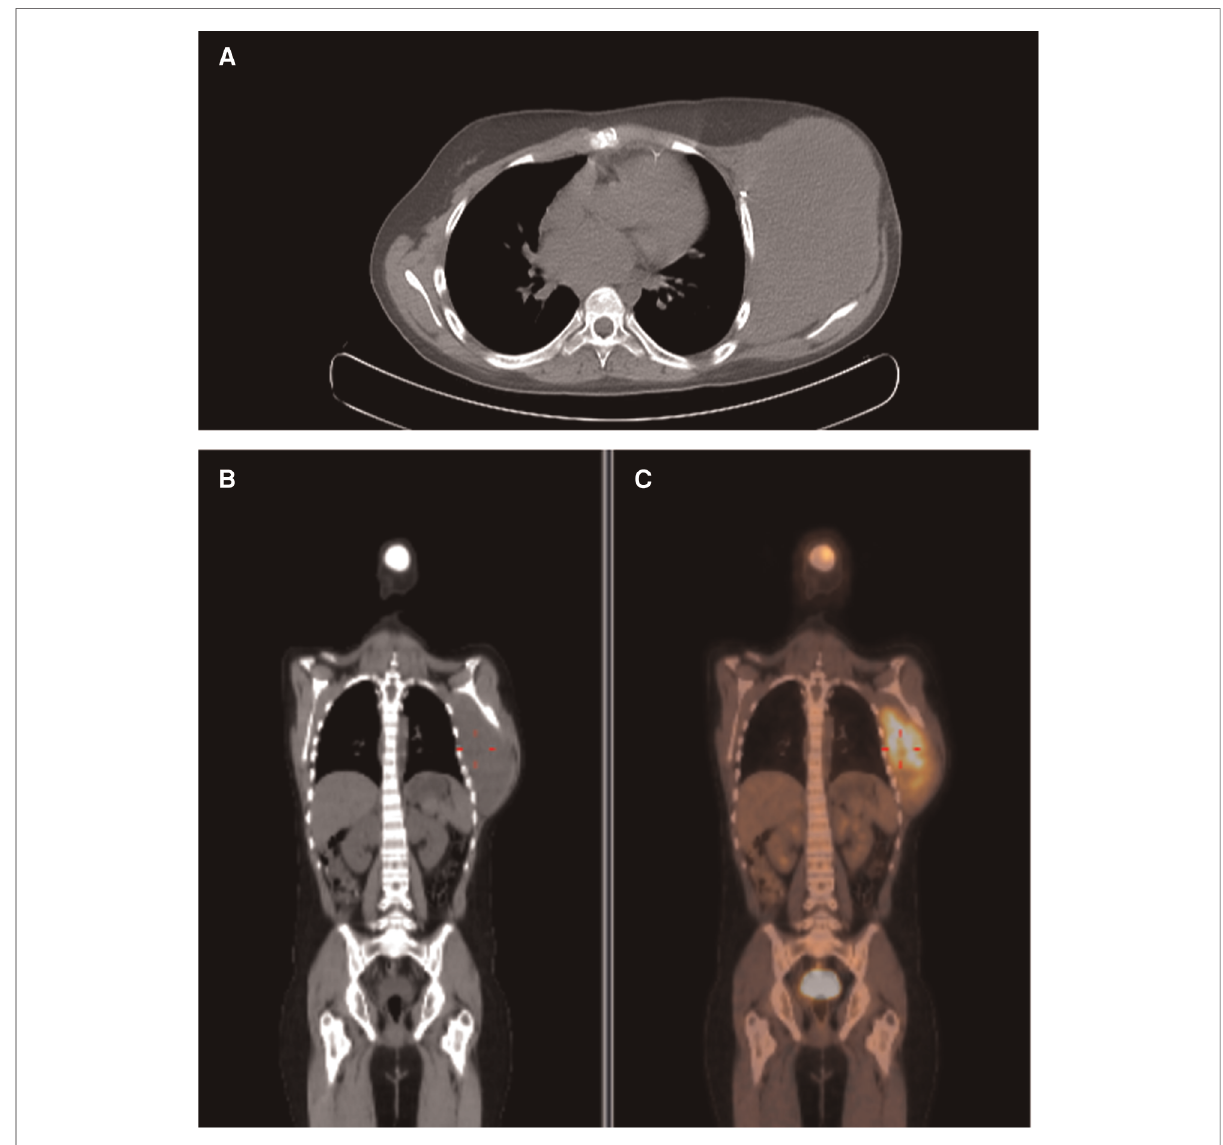
FIGURE 1 Preoperative PET image. Captant area in thoracic wall with SUVmax: 7.8. ( A ) Axial image. ( B ) Coronal image. ( C ) Coronal fusion